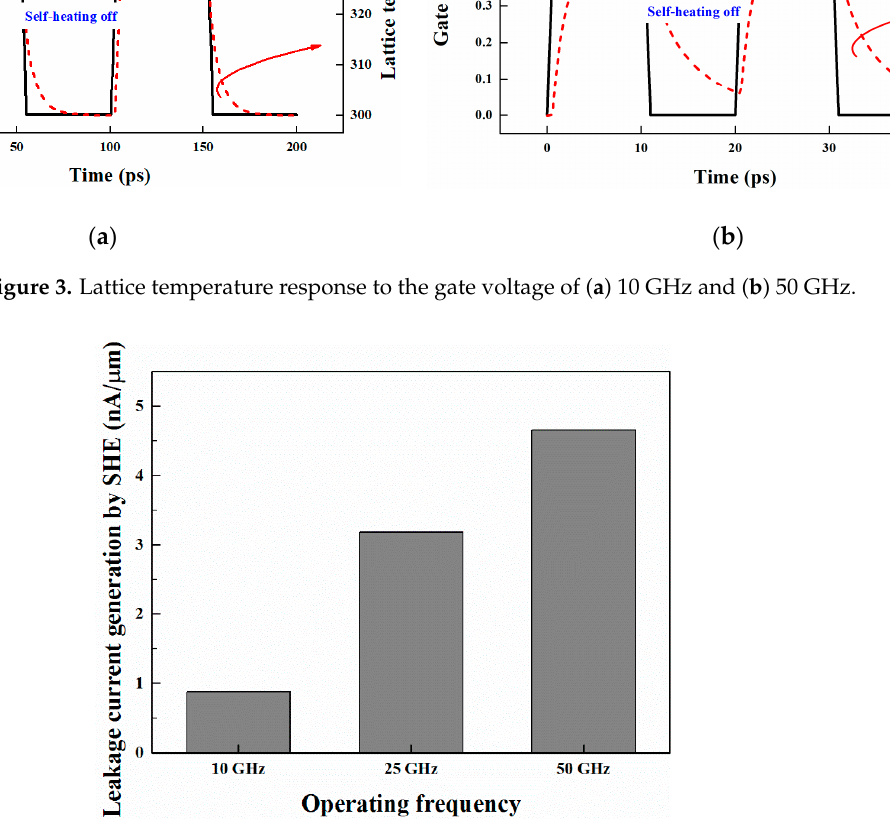
Figure 4. Leakage current generation by the SHE at the off-phase of the pulse.